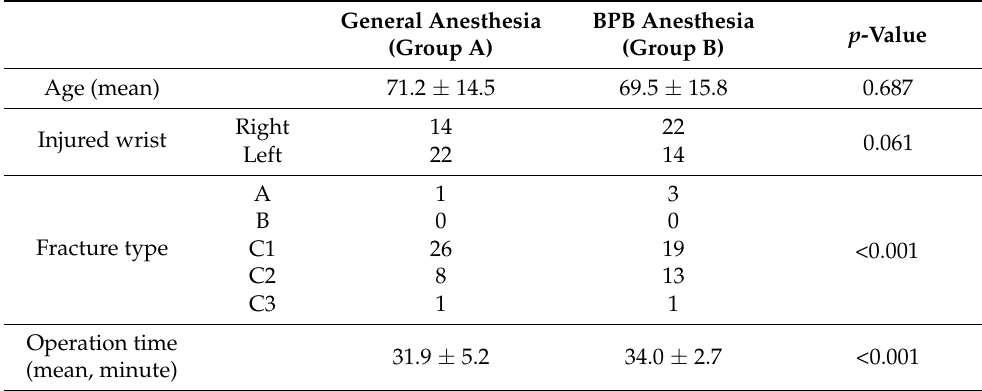
Table 1. Demographic data of patients treated with volar plating for distal radius